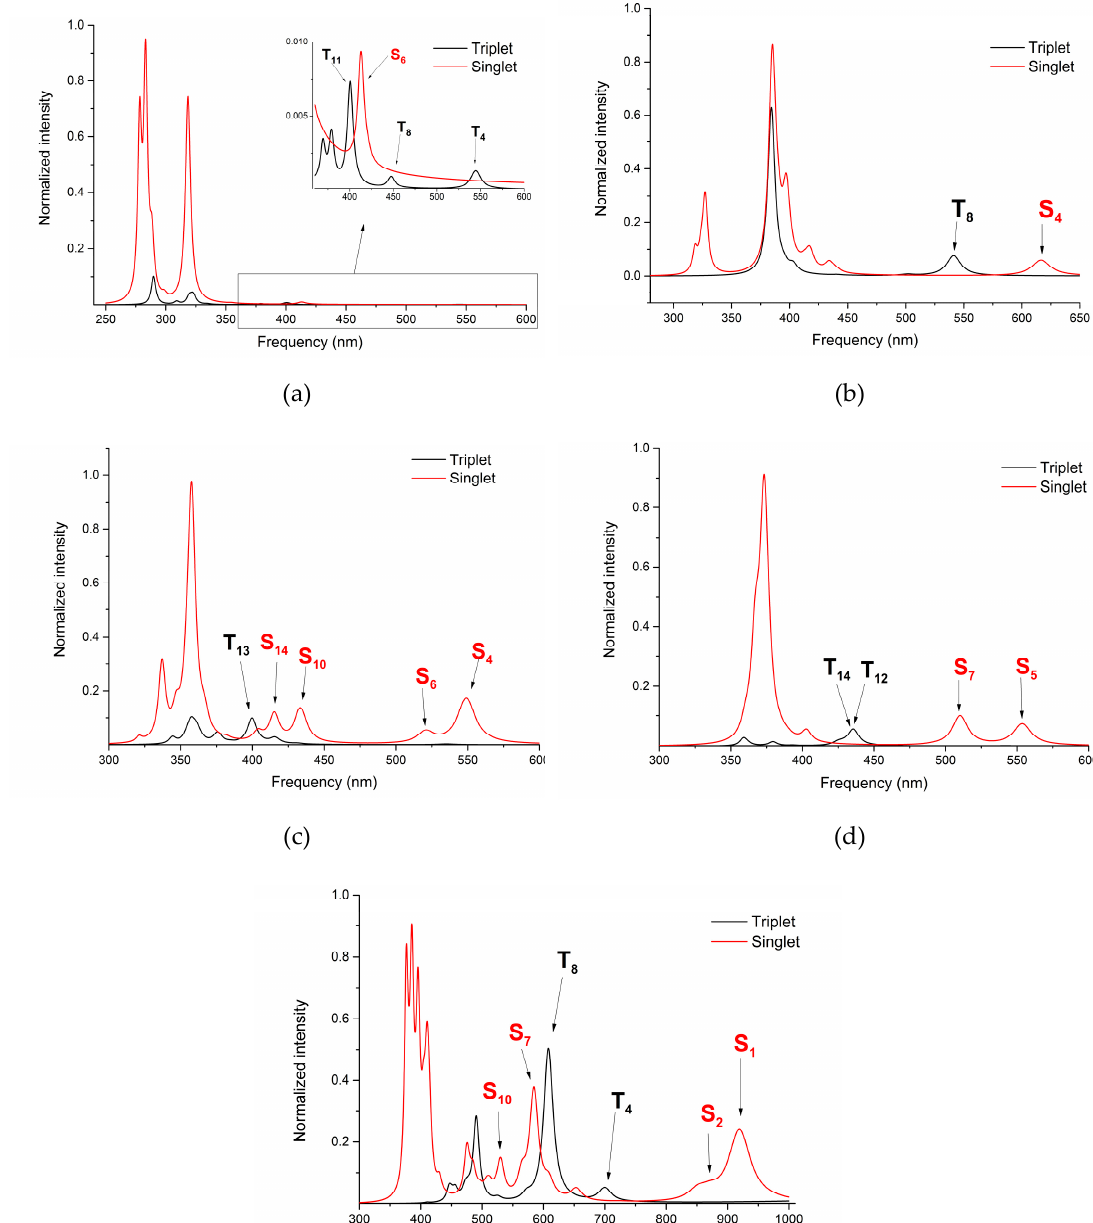
Figure 4. The UV absorption spectra calculated for the singlet and triplet spin states of the ( a ) C1, ( b ) C2, ( c ) C4, ( d ) C5, and ( e ) C6 metal-organic complexes obtained at TD-DFT/M06/Def2-TZVP level of theory. TD-DFT, time-dependent density functional theory.